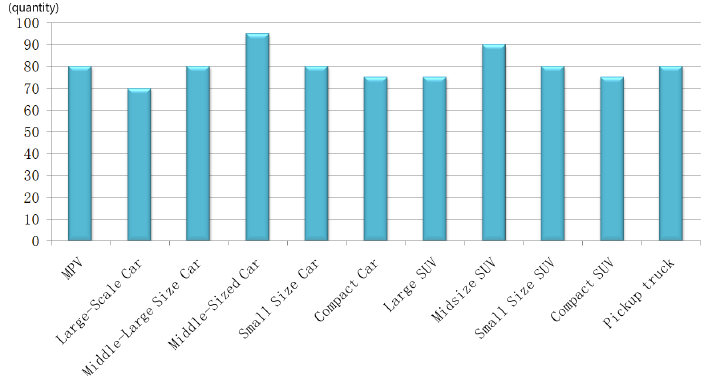
Figure 13. Volkswagen affiliate diagram.